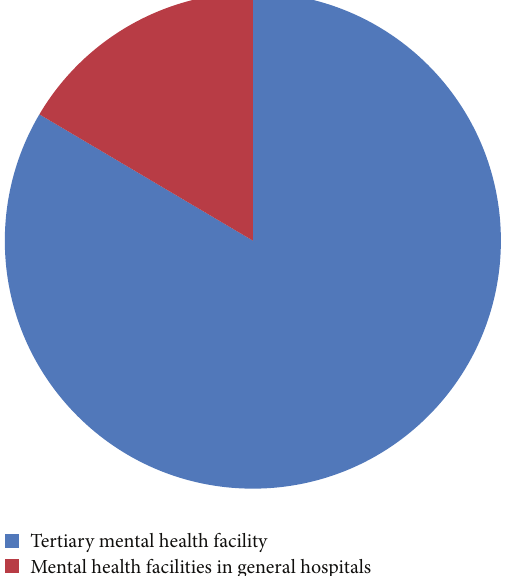
Figure 4: Proportion of mentally ill patients attending the mental health facilities in the